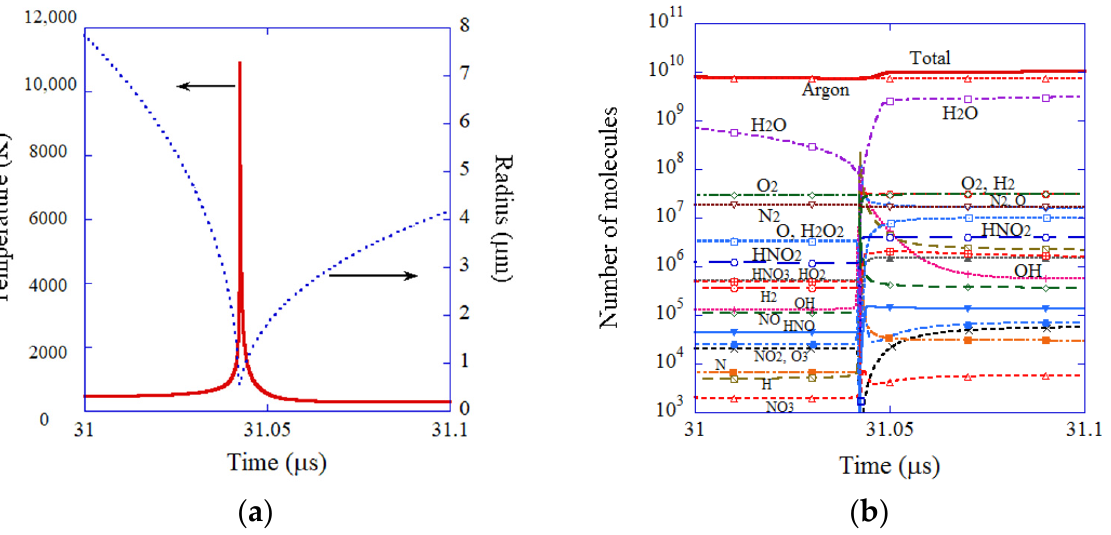
Figure 4. The results of numerical simulation of the ODE model for single-bubble sonochemistry at around the end of the violent bubble collapse ( a ) The bubble radius (blue dotted line) and temperature (red solid line). ( b ) The number of molecules inside a bubble with logarithmic vertical axis. Reprinted with permission from Ref. [74]. Copyright 2005, AIP